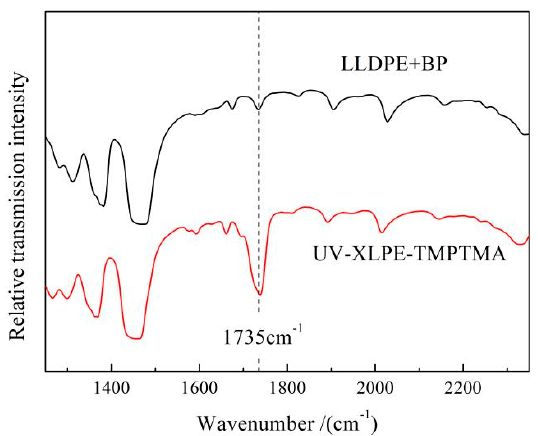
Figure 2. Infrared transmission spectra of LLDPE + BP mixture and UV-XLPE-TMPTMA.